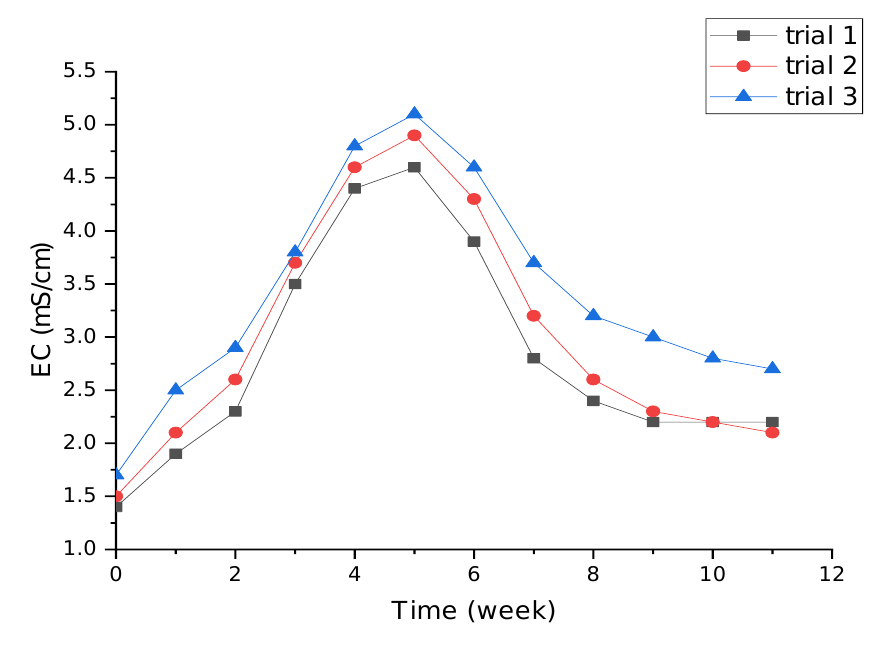
Fig. 6 Electrical conductivity of the composting